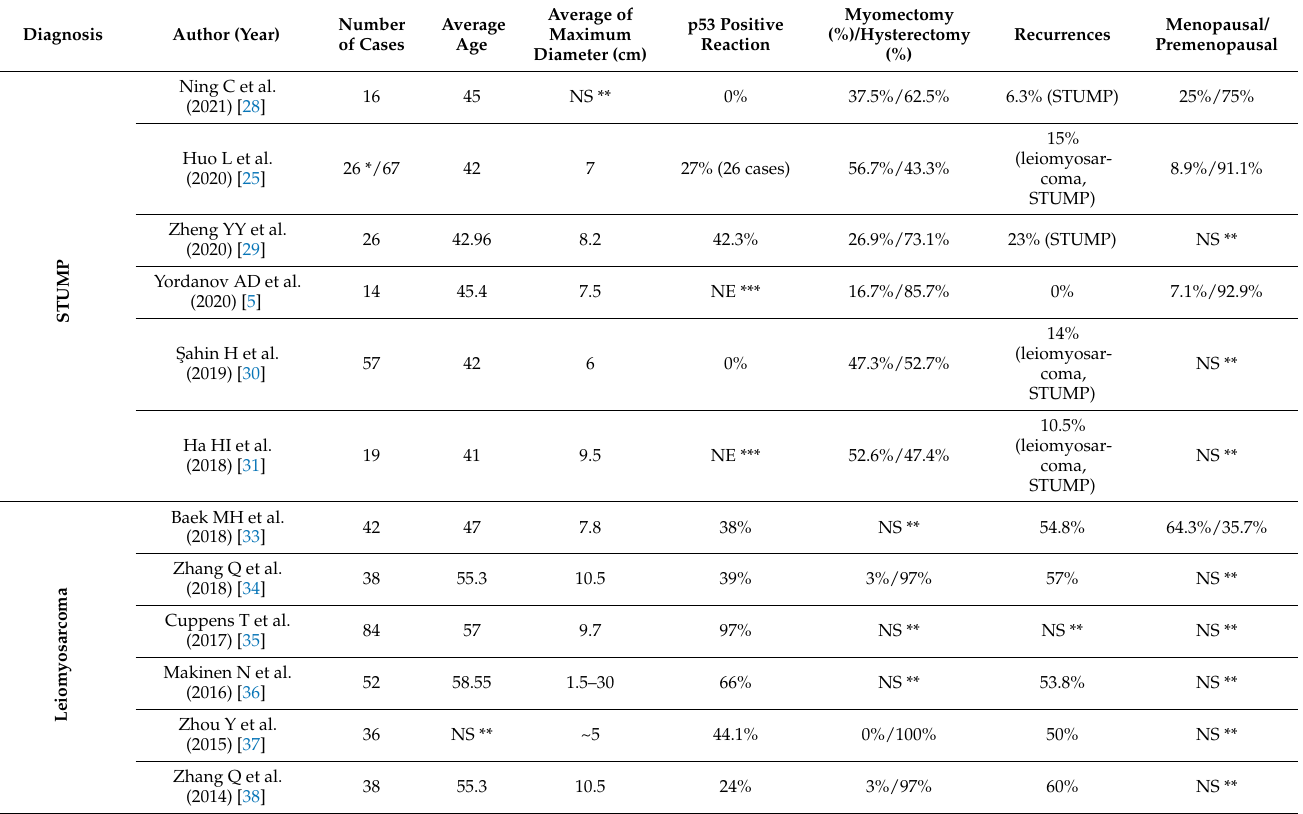
Table 1. The main studies analyzing the immunoreaction of the p53 marker in cases of uterine leiomyosarcoma and STUMP.